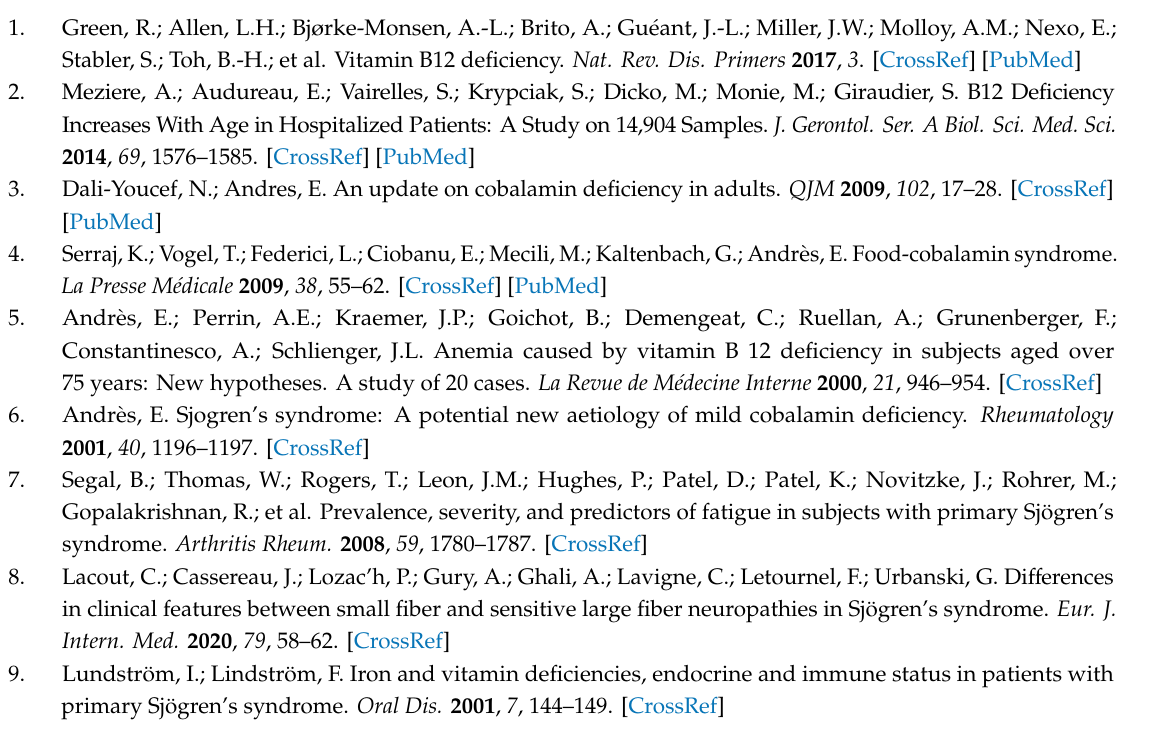
Table S1: Characteristics of pSS patients according to B12